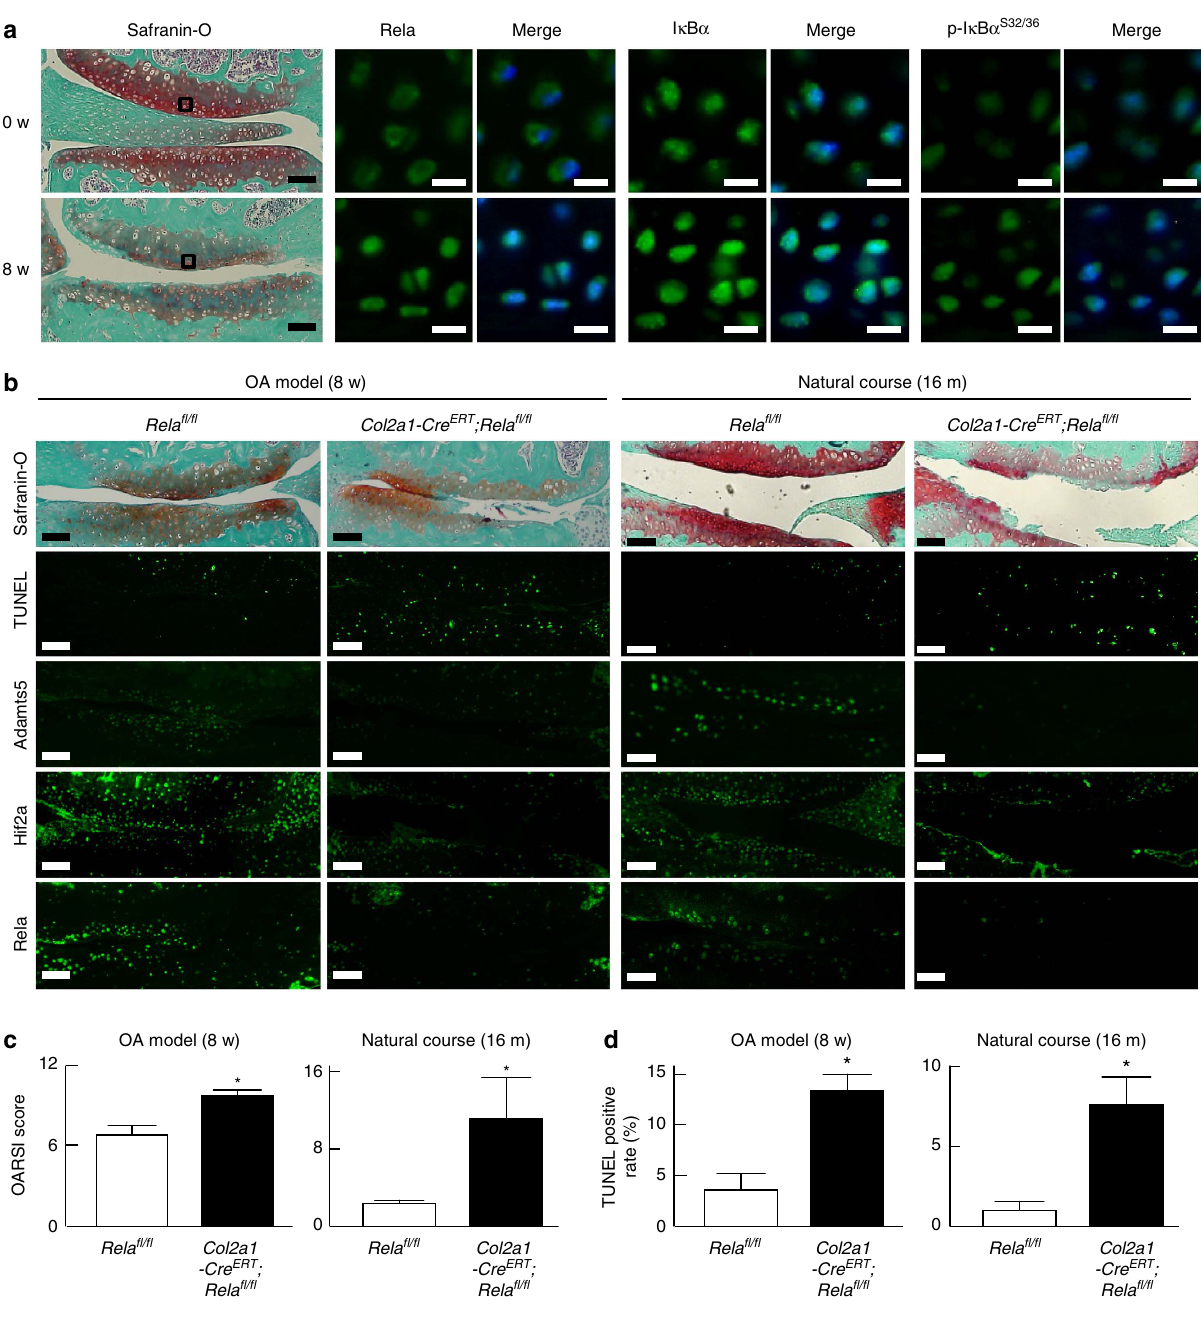
Figure 4 | Regulation of OA development by Rela. ( a ) Safranin-O staining and immunofluorescence of Rela, I k B a , and Ser 32 and 36 dual phosphorylated I k B a proteins in knee joint cartilage of an 8-week-old mouse (0 w) and at 8 weeks after surgery (8 week) to induce OA. Boxes in the Safranin-O staining panels indicate the regions of immunofluorescence. The images are representative of three independent experiments. Scale bars, 100 and 10 m m for Safranin-O staining and immunofluorescence, respectively. ( b ) Safranin-O, TUNEL staining and immunofluorescence of Adamts5, Hif2a and Rela in knee joint cartilage of Rela fl/fl and Col2a1-Cre ERT ; Rela fl/fl mice at 8 weeks after surgery (OA model, n ¼ 7 and 10, respectively, left panels), and Rela fl/fl and Col2a1- Cre ERT ; Rela fl/fl mice at 16 months of age (natural course, n ¼ 5 for each, right panels). Tamoxifen induction was performed at 7 weeks. The images are representative of three independent experiments. Scale bars, 100 m m. ( c ) OARSI (Osteoarthritis Research Society International) score of OA development. Data are expressed as the means ± s.d. of the mice per group. * P o 0.05 versus Rela fl/fl mice; Welch’s t -test. ( d ) Rate of TUNEL-positive cells in articular cartilage. Data are expressed as the means ± s.d. of five mice per group. * P o 0.05 versus Rela fl/fl mice; Student’s t